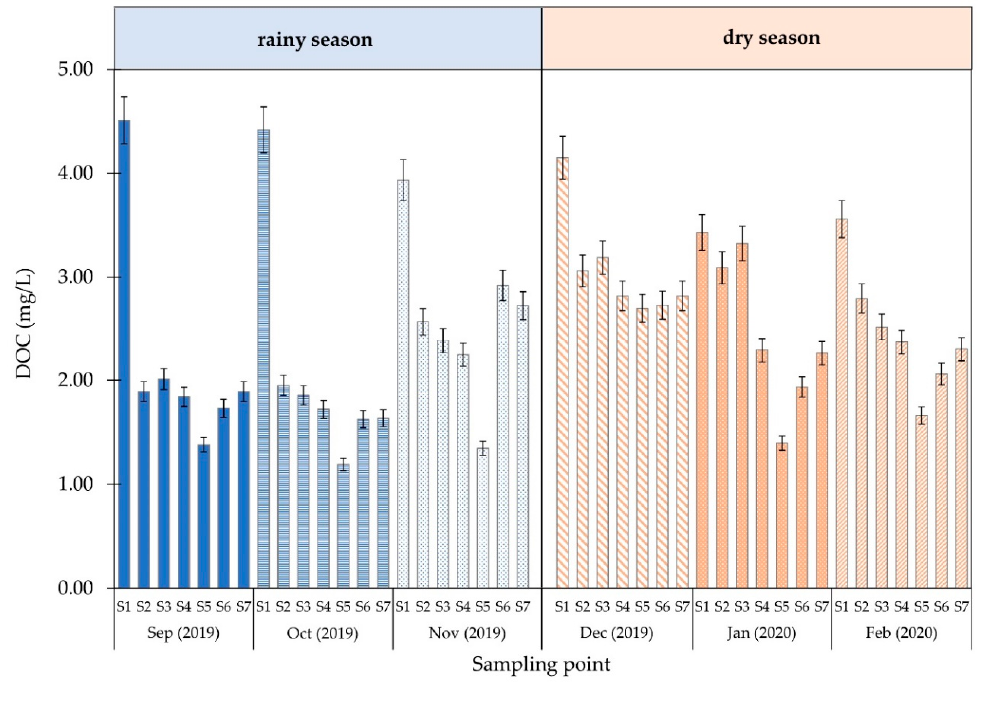
Figure 4. DOC of water at each sampling point.